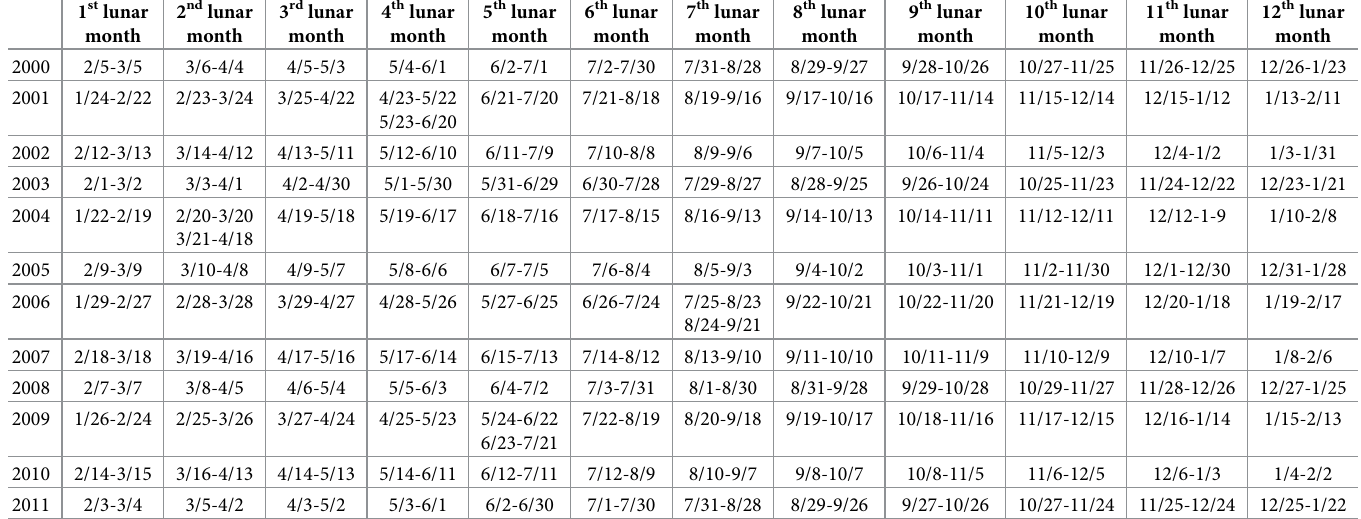
Table 1. The corresponding Gregorian calendar dates of lunar months from 2000 to